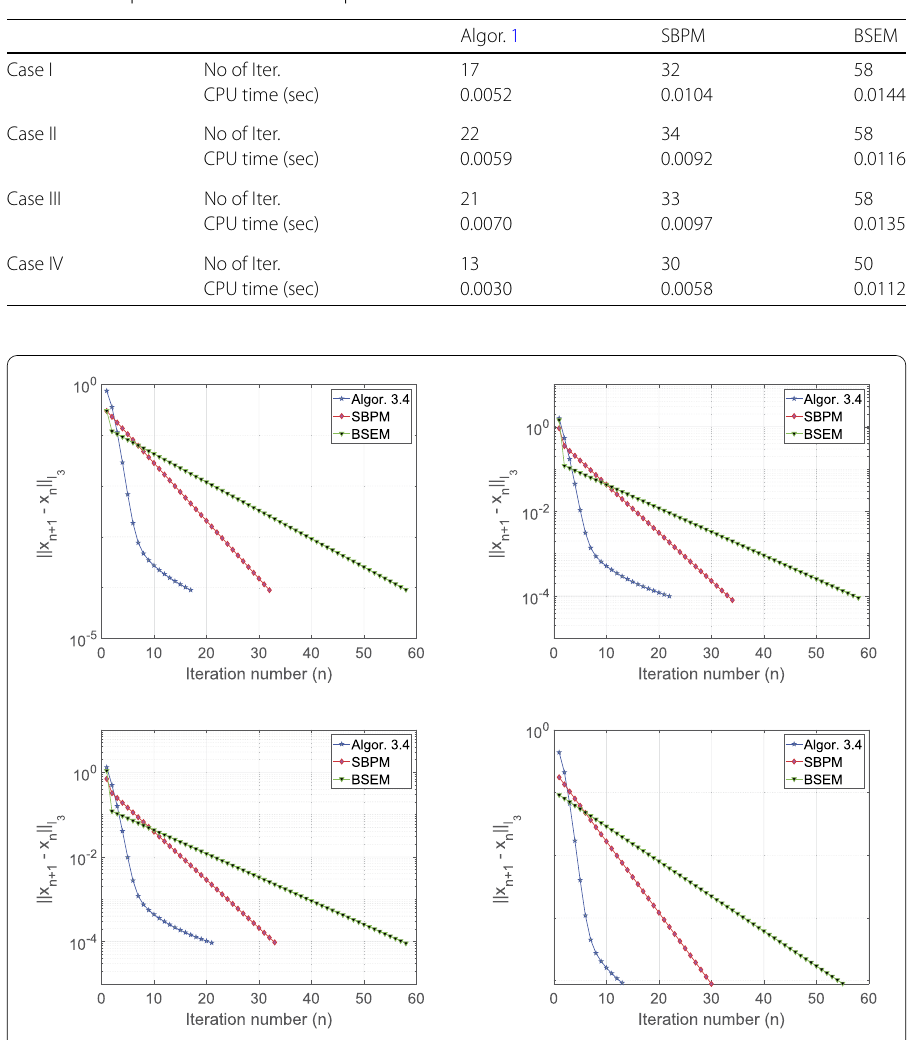
Table 3 Computation result for Example 5.3